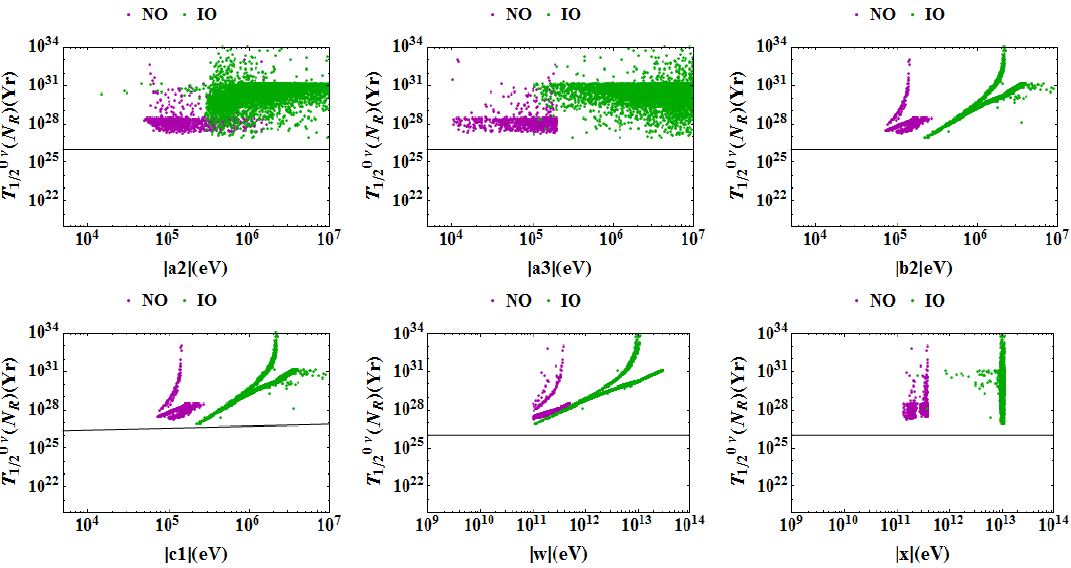
Figure 11 . Heavy (cid:23) (N) contribution to half-life governing NDBD as a function of model param- eters for the class B1. The horizontal line represents the KamLAND-Zen lower limit.